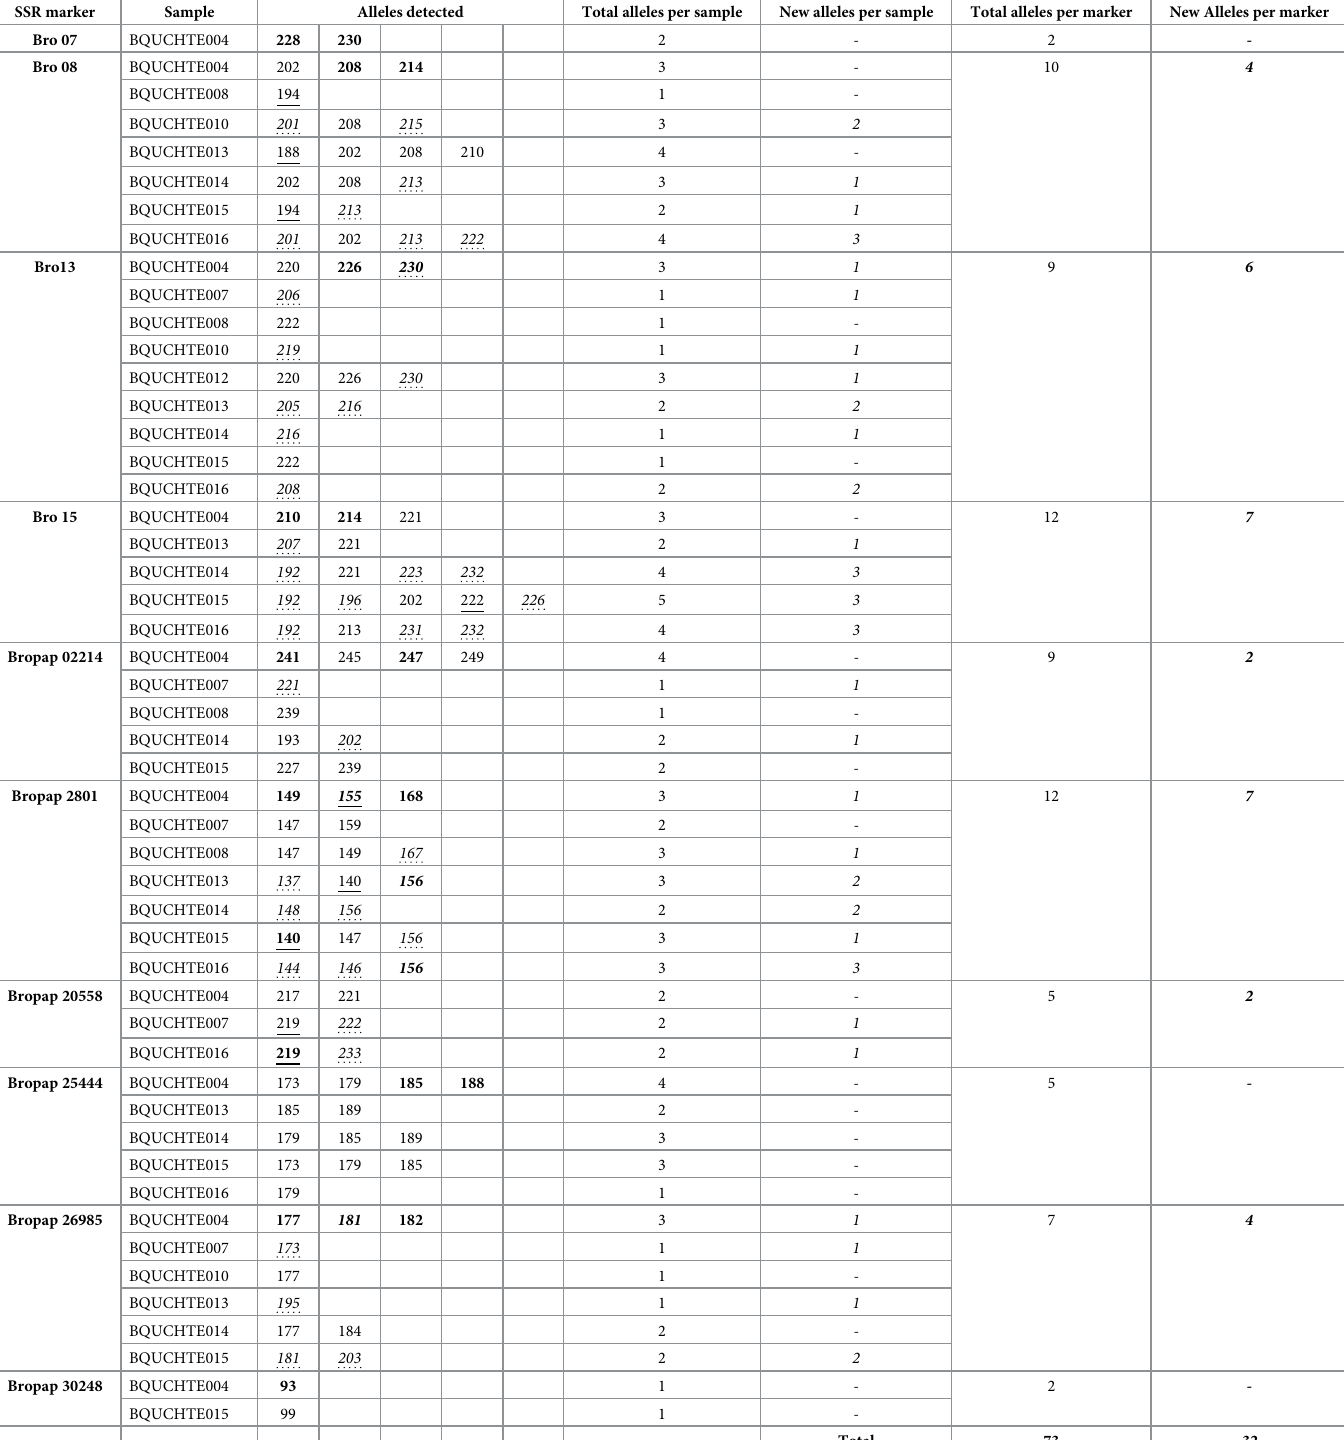
Table 3. Summary of alleles found per marker and sample.